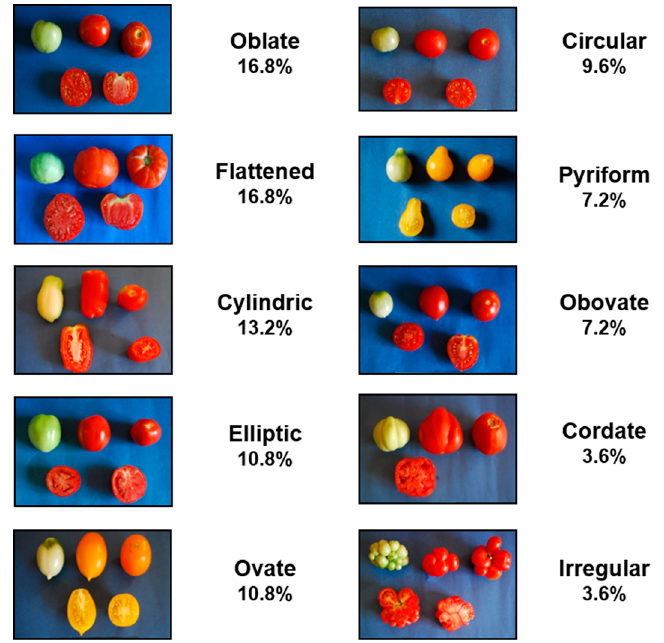
Figure 1. Variability of fruit morphology exhibited by the tomato landraces used as genetic resources. The percentage of landraces belonging to each fruit type is reported.